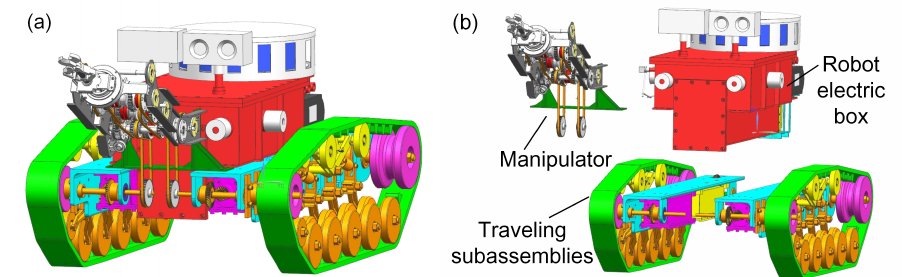
Figure 4. The coal mine search-and-rescue robot 3D model is shown in ( a ), the robot explosion structure is shown in ( b ).